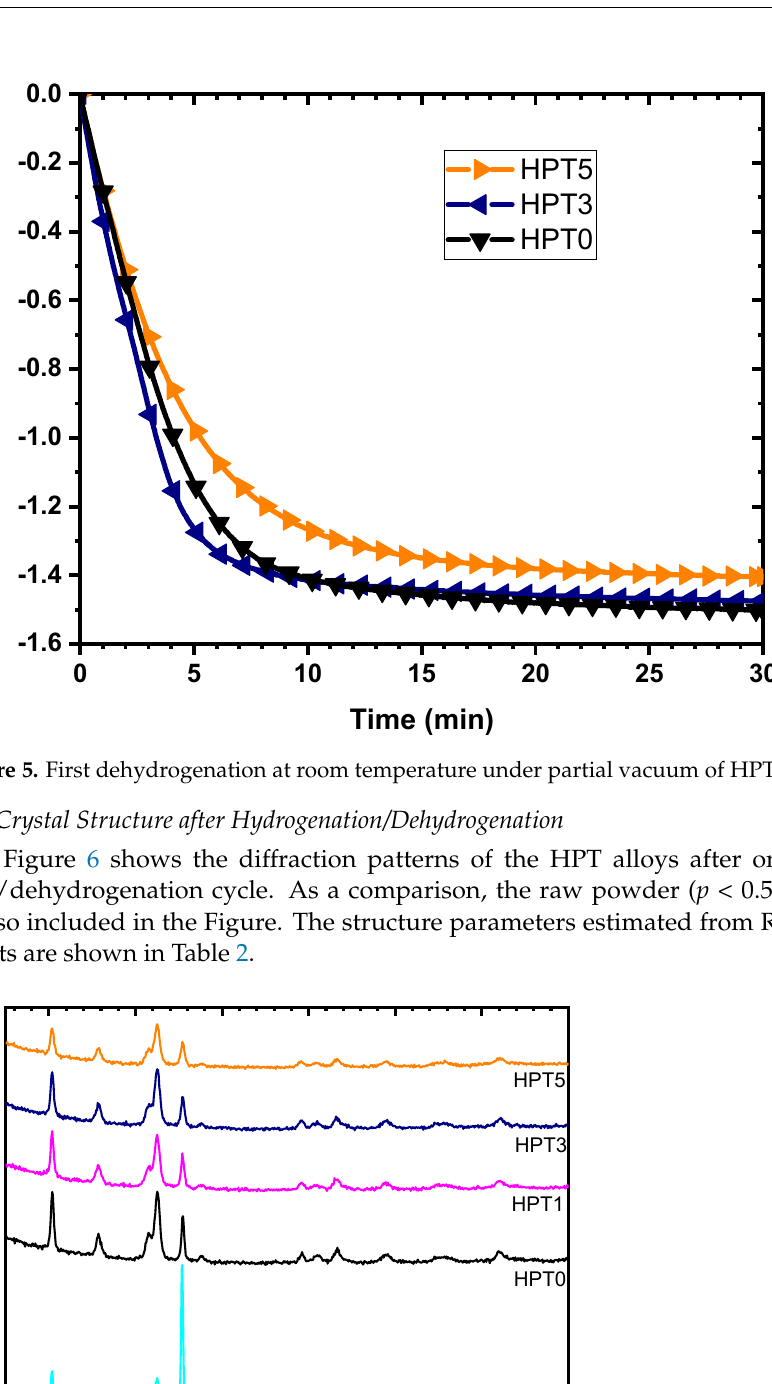
7 of 11 Figure 4. First hydrogenation at room temperature under 1500 kPa of hydrogen of samples after various HPT turns. Figure 5 shows the first dehydrogenation of samples HPT0, HPT3 and HPT5. Due to uncontrolled experimental conditions, the HPT1 desorption was not registered. For all experiments, the final pressure was around 25 kPa. We observed that the desorption is